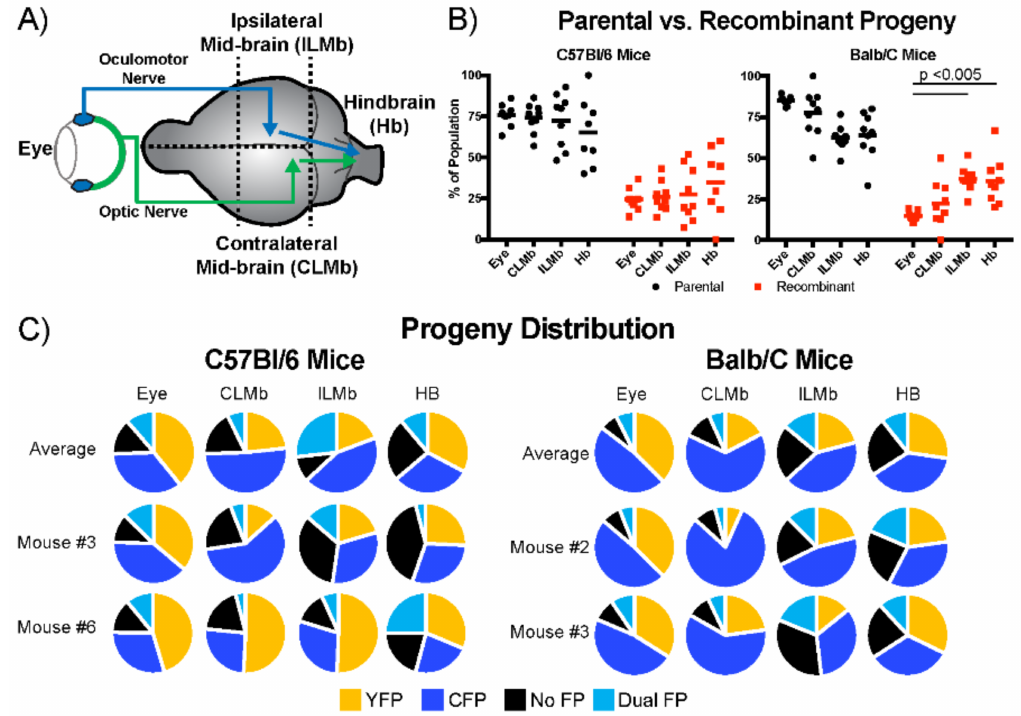
Figure 5. Effect of neuroinvasive spread on populations of viruses in vivo. ( A ) A schematic of the murine eye model for neuroinvasive spread; ( B ) frequency of parental progeny and recombinant progeny obtained from the eye, contralateral midbrain (CLMb), ipsilateral midbrain (ILMb), and hindbrain (Hb). Data presented are the summation of the two experiments for both C57Bl/6 and Balb/C mice. Each experiment contained between four and five mice; ( C ) distribution of FP distributions from the eye, CLMb, ILMb, and Hb are plotted. The top row shows the average distribution of plaques for the our sites in both C57Bl/6 and Balb/C mice. The lower rows are two example distributions from independent mice from each experimental group. Significant differences indicated were identified by two-way ANOVA